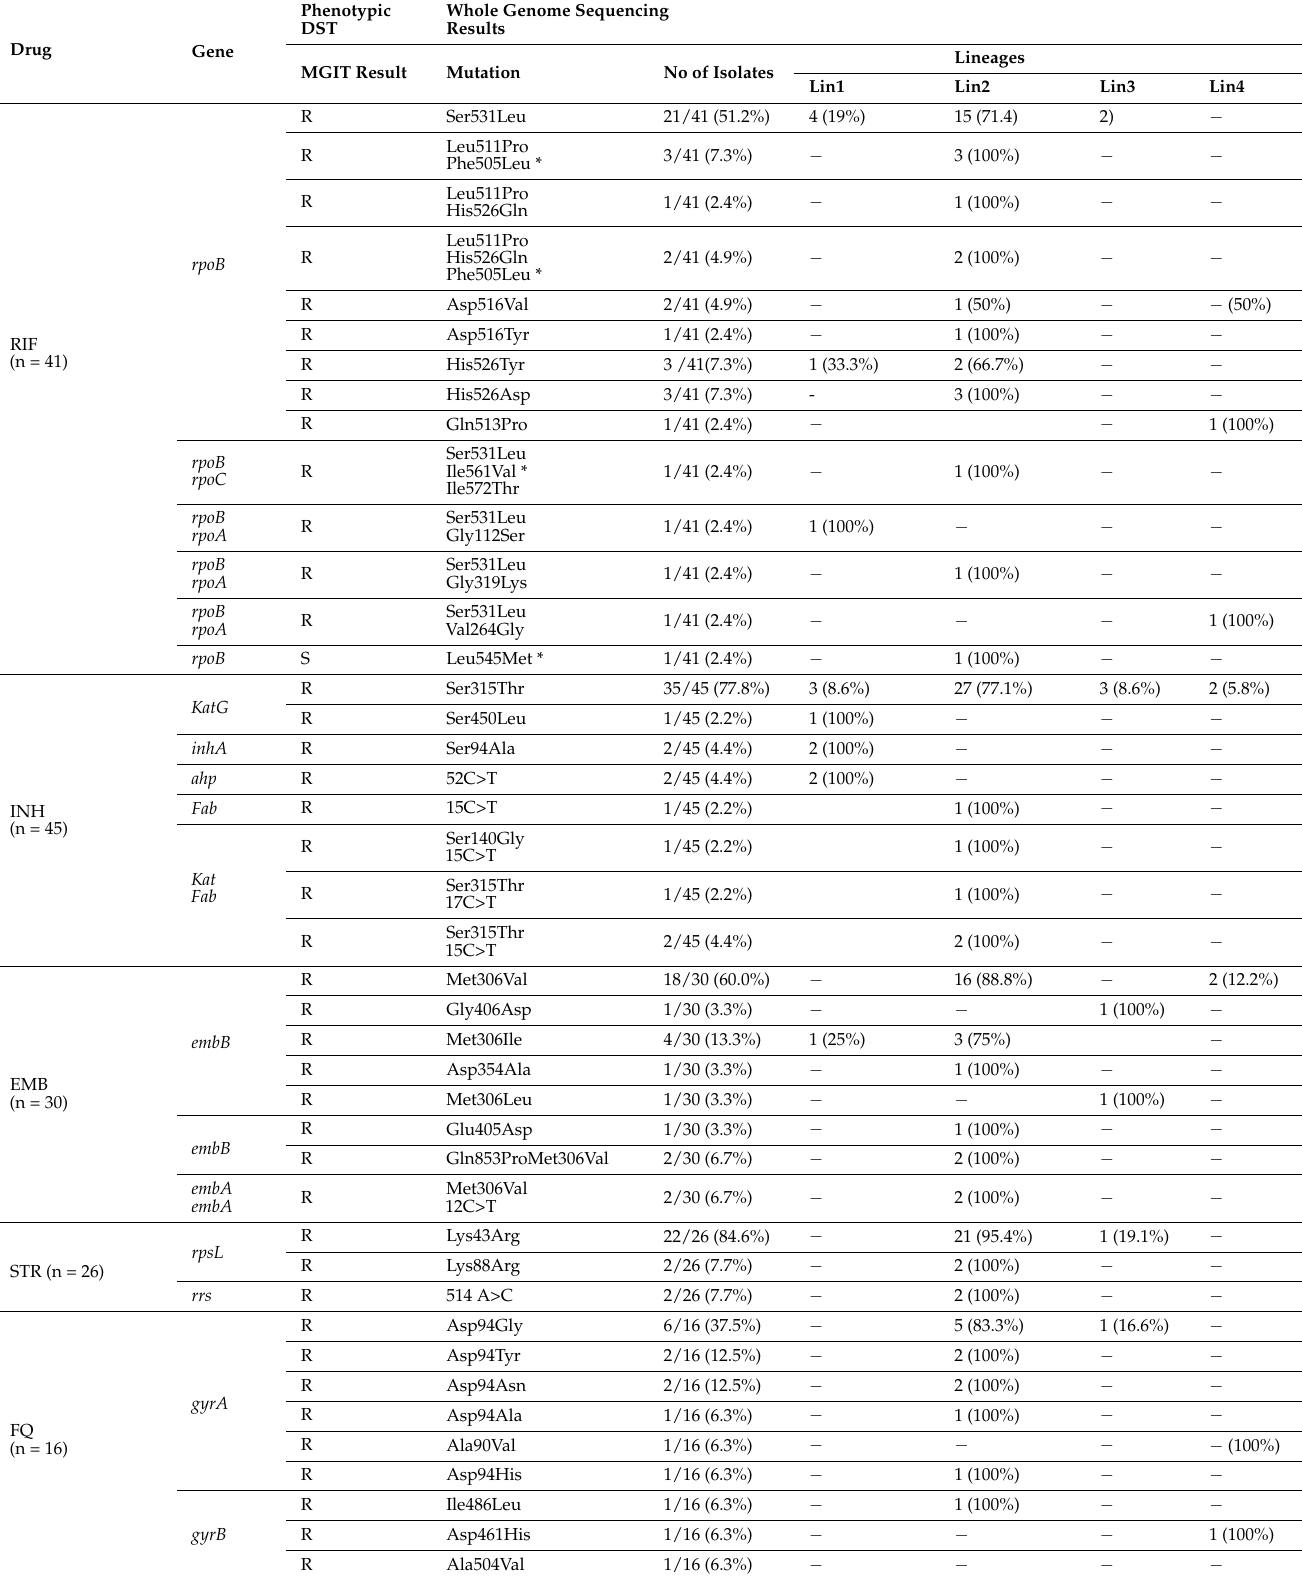
Table 2. Patterns of mutation resulting from WGS analysis and their association with phenotypic